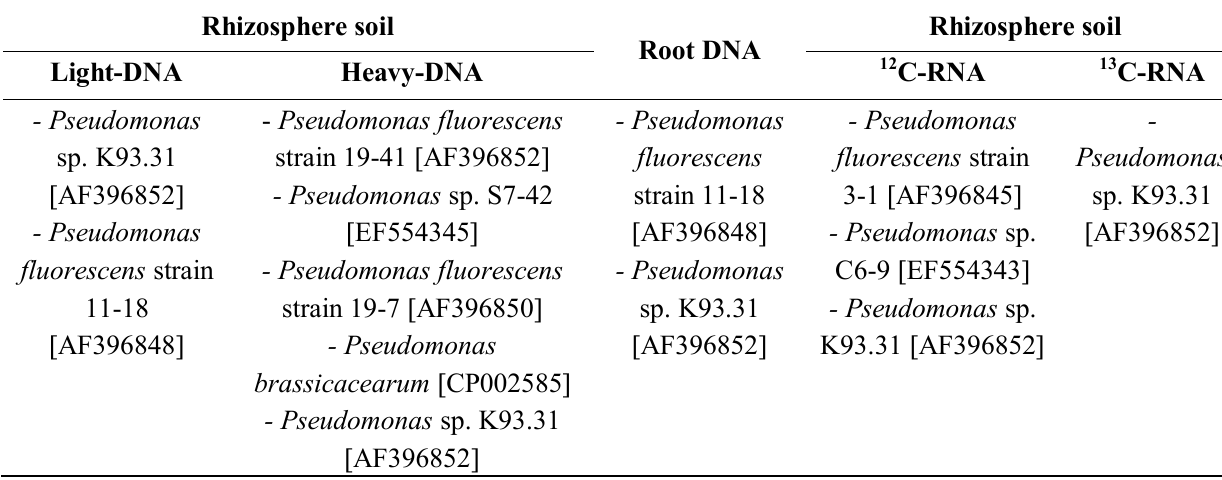
Table 1. Phylogenetic affiliation of phlD sequences corresponding to Denaturing Gradient Gel Electrophoresis (DGGE) prominent bands retrieved from root DNA (R-DNA) and RNA (R-RNA), heavy and light DNA fractions and 12 C- and 13 C-RNA fractions. No amplification was detected from RNA extracted from root system. Accession numbers for the BlastN matches are indicated in brackets.